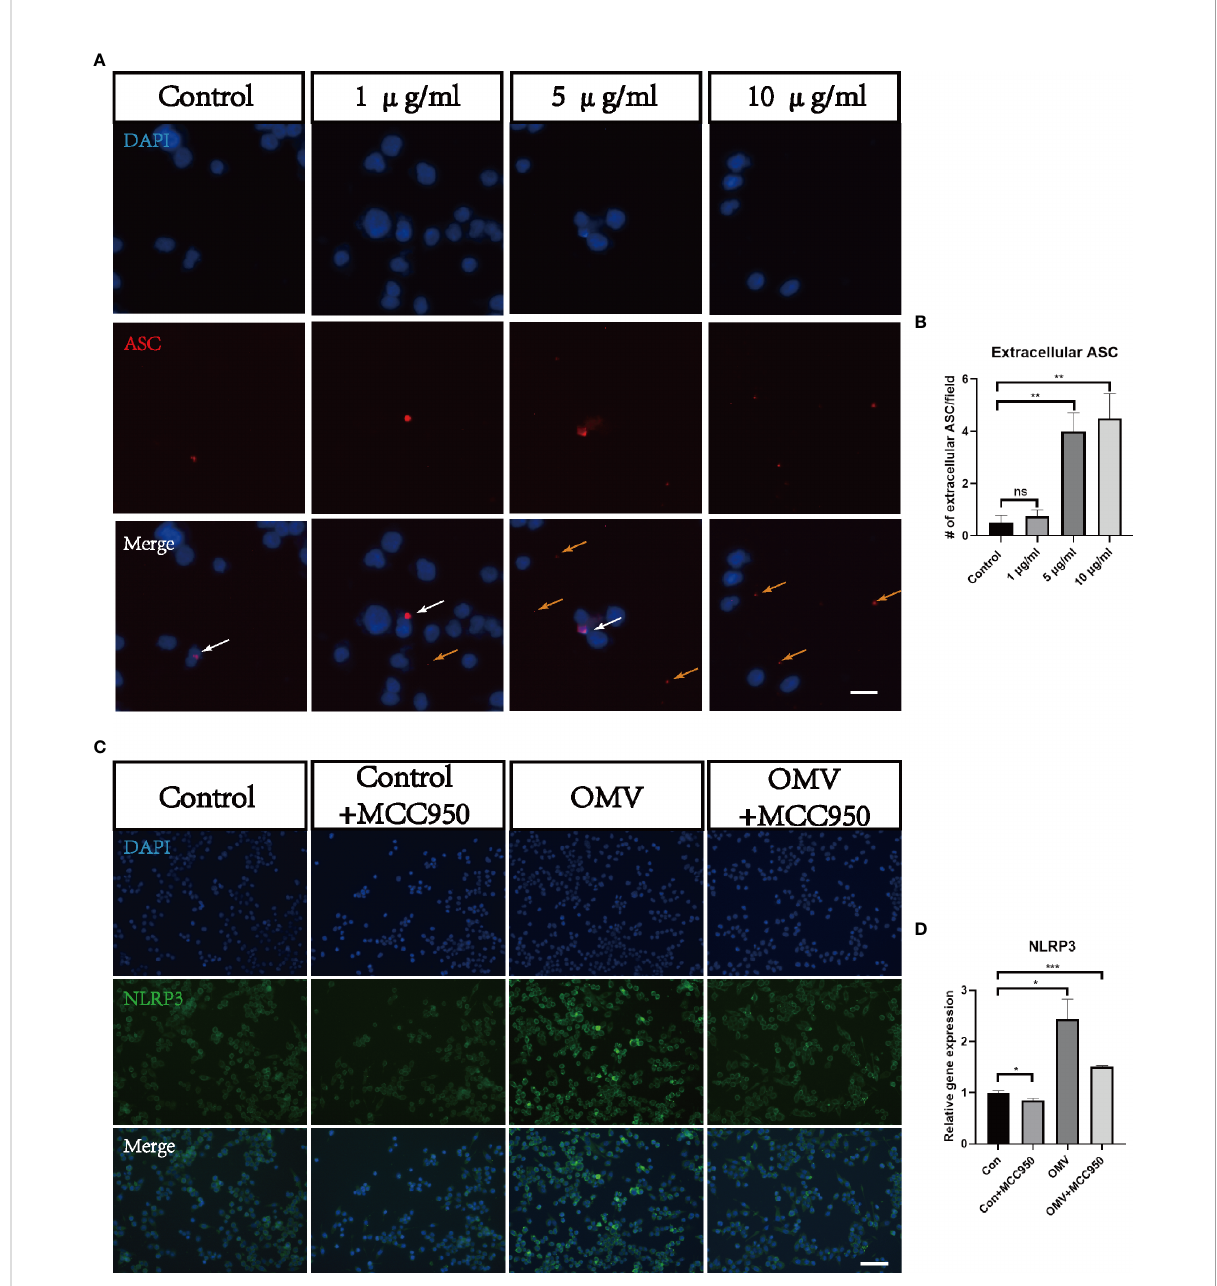
FIGURE 9 Pg OMVs triggers NLRP3 in fl ammasome in microglia in vitro . (A) Immuno fl uorescent images showed intracellular ASC (white arrow) and extracellular ASC (yellow arrows) of BV2 cells stimulated with different concentrations of Pg OMVs. Scale bar = 10 m m. (B) Number of extracellular ASC per fi eld. ( n =4, ns, not signi fi cant, ** p <.01). (C) Immuno fl uorescent images showed NLRP3 staining of BV2 cells stimulated by Pg OMVs. MCC950 (20 m M) were used for pretreatment for one hour. (D) The mRNA expression of NLRP3 in BV2 cells stimulated by Pg OMVs. MCC950 (20 m M) were used for pretreatment for one hour. (n=3, *p